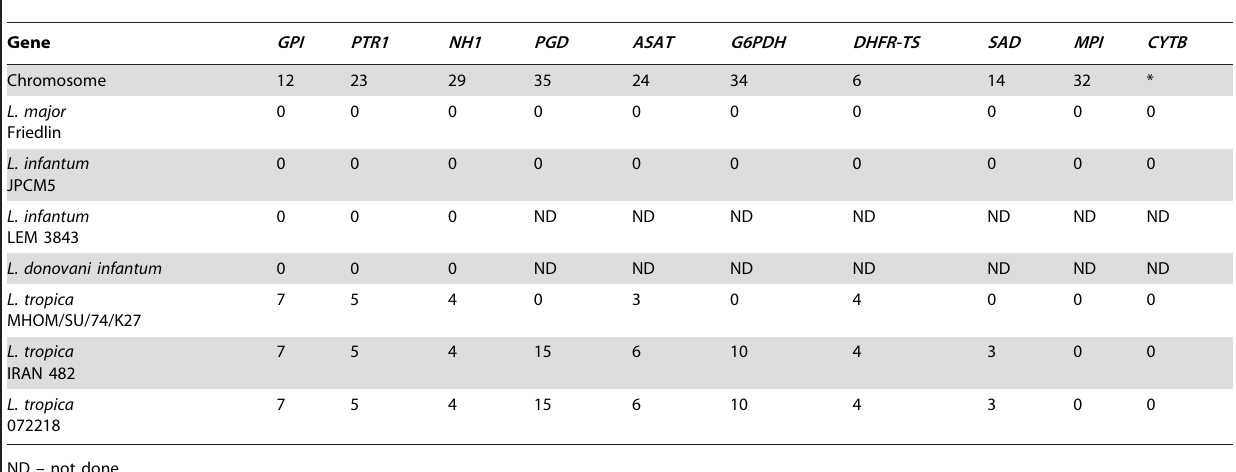
Table 2. Single nucleotide polymorphisms within Leishmania species for 10 genes a .